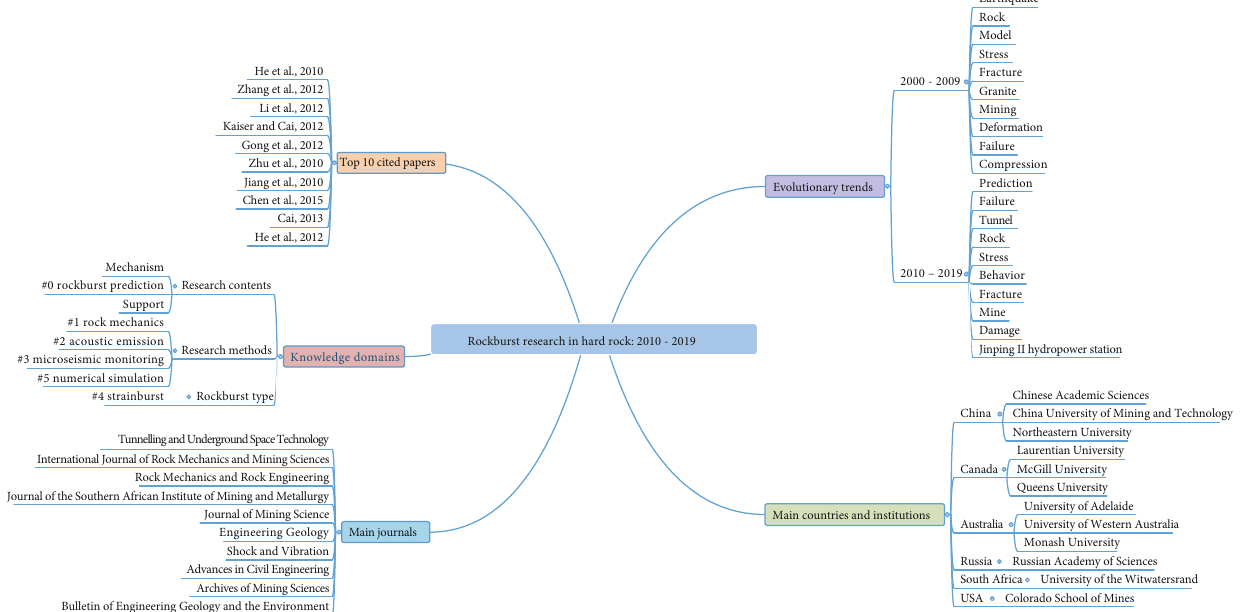
Figure 15: Comprehensive knowledge map of rockburst research in hard rock: